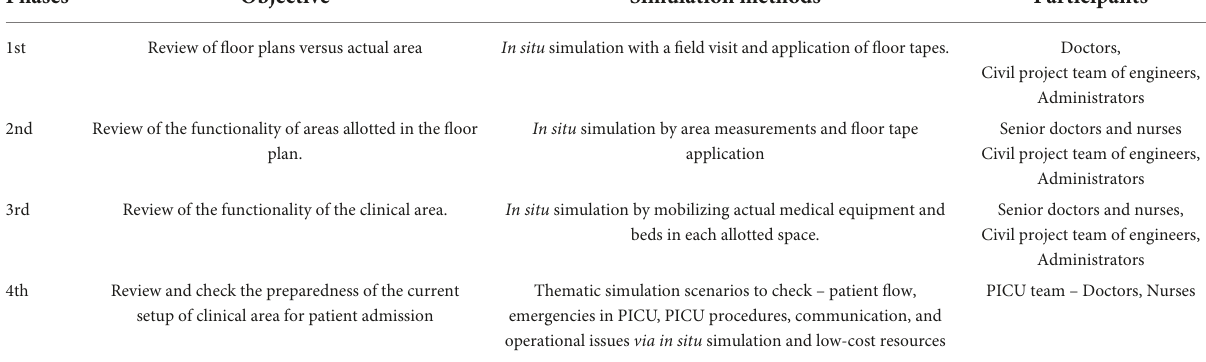
TABLE 1 Four phases of simulation in the design of